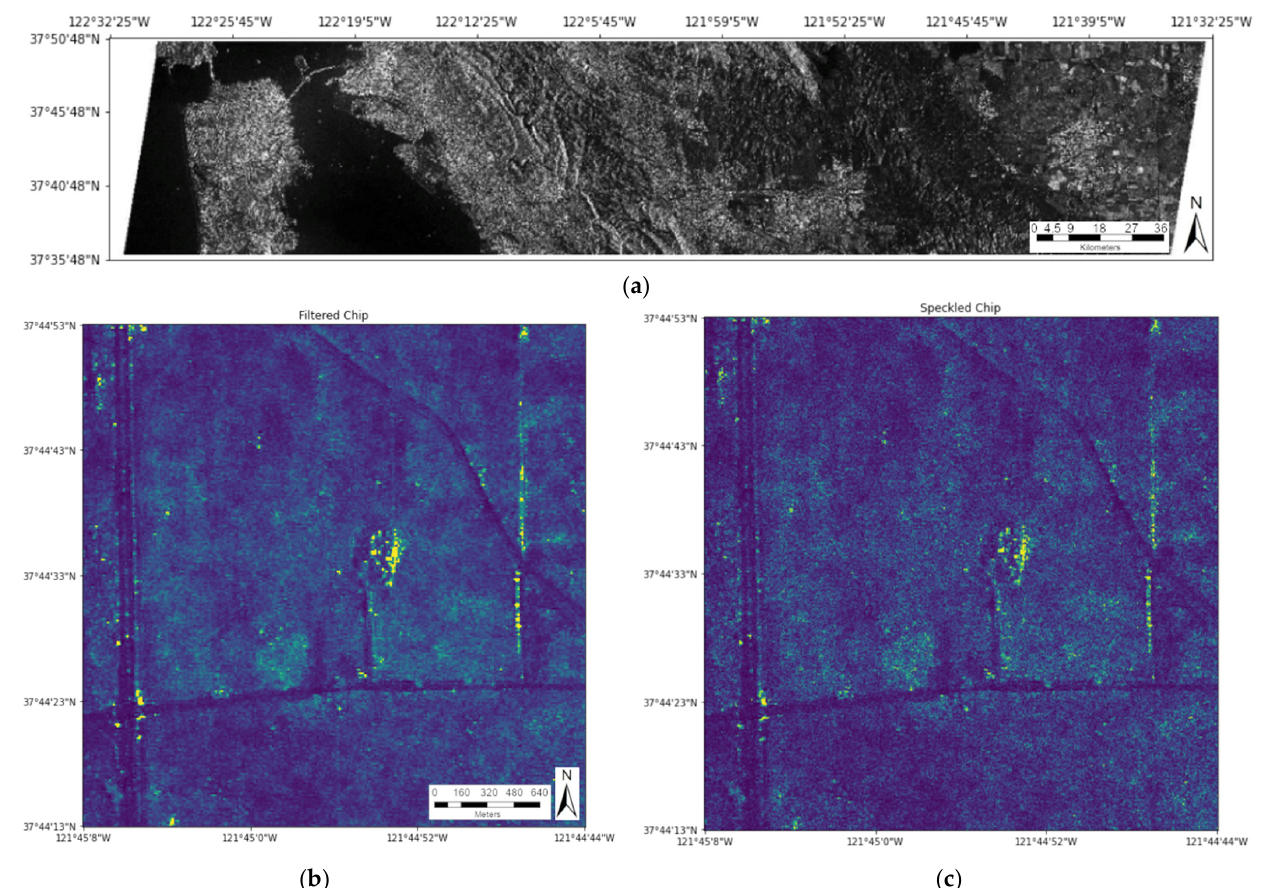
Figure 1. ( a ) The complete SAR image prior to chipping into 512 × 512 px regions for model ingestion. ( b ) Image chip after multi-temporal filtering, from the ID dataset. ( c ) The same image chip with speckle from the out-of-distribution (OOD) dataset. The speckled images have much noisier texture, which results in a different data distribution and poorer segmen- tation quality than filtered counterparts (note that a model trained on speckled images would have poorer performance with filtered images).